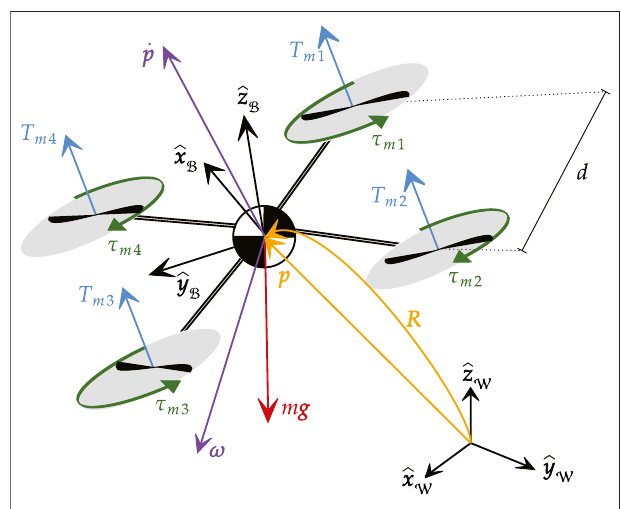
FIGURE 1 | Schematic representation of a quadrotor